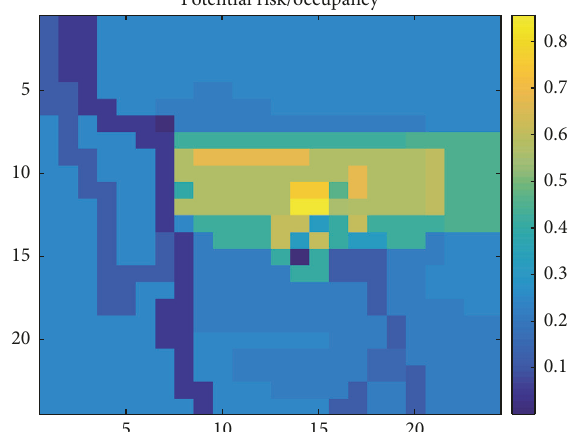
Figure 4: La Palma potential risk/occupancy